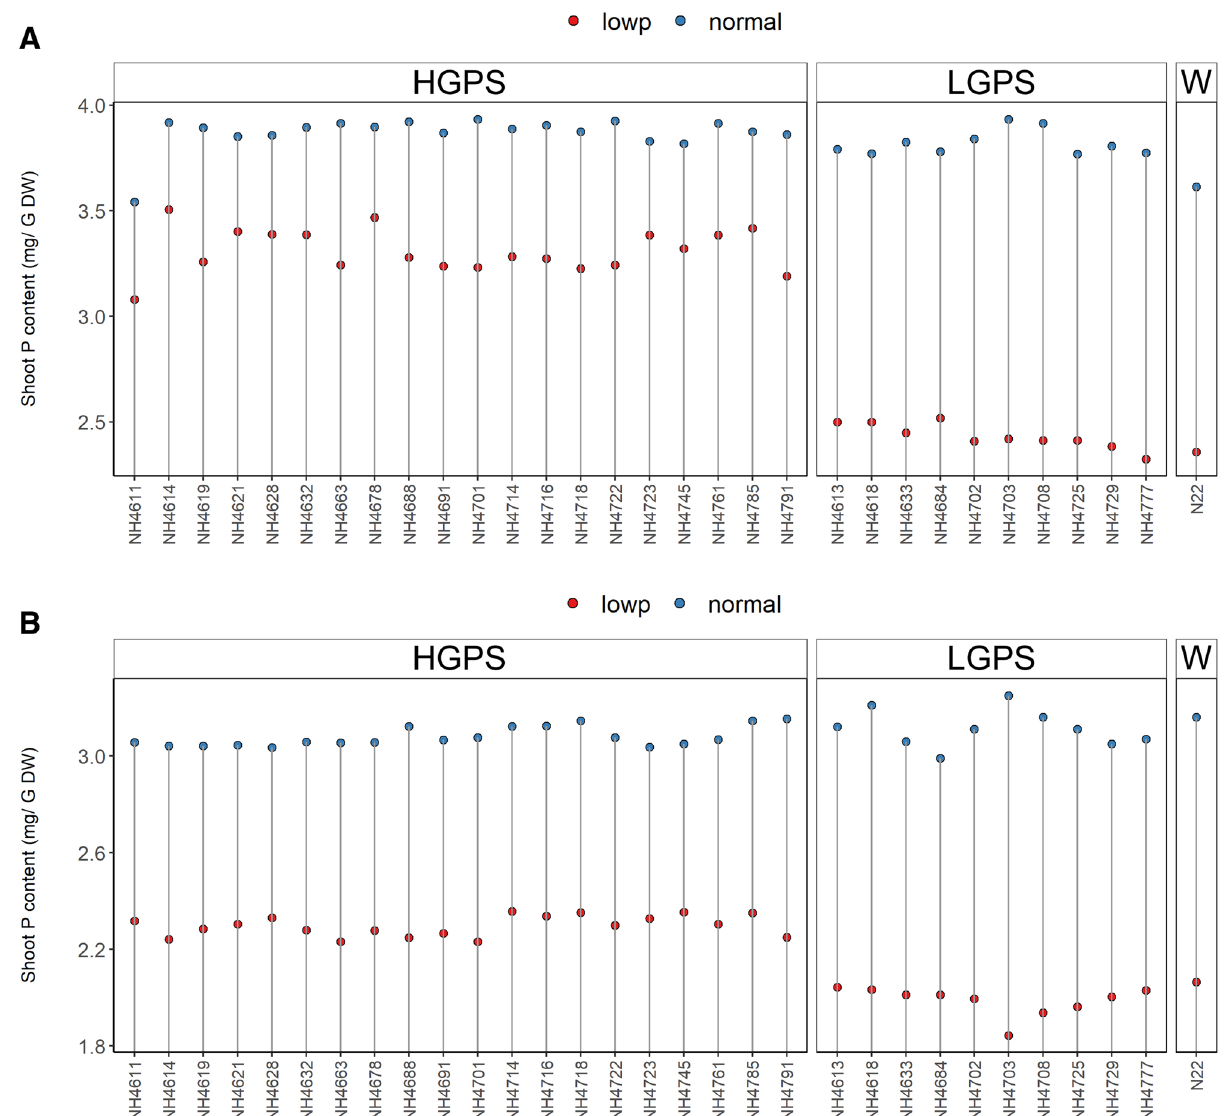
and low grain P mutant seedlings (LGPS) were grown under normal P condition. ( A ) Shoot P content at 12 days of germination. ( B ) Shoot P content at 24 days of germination. The values represent the mean of 6